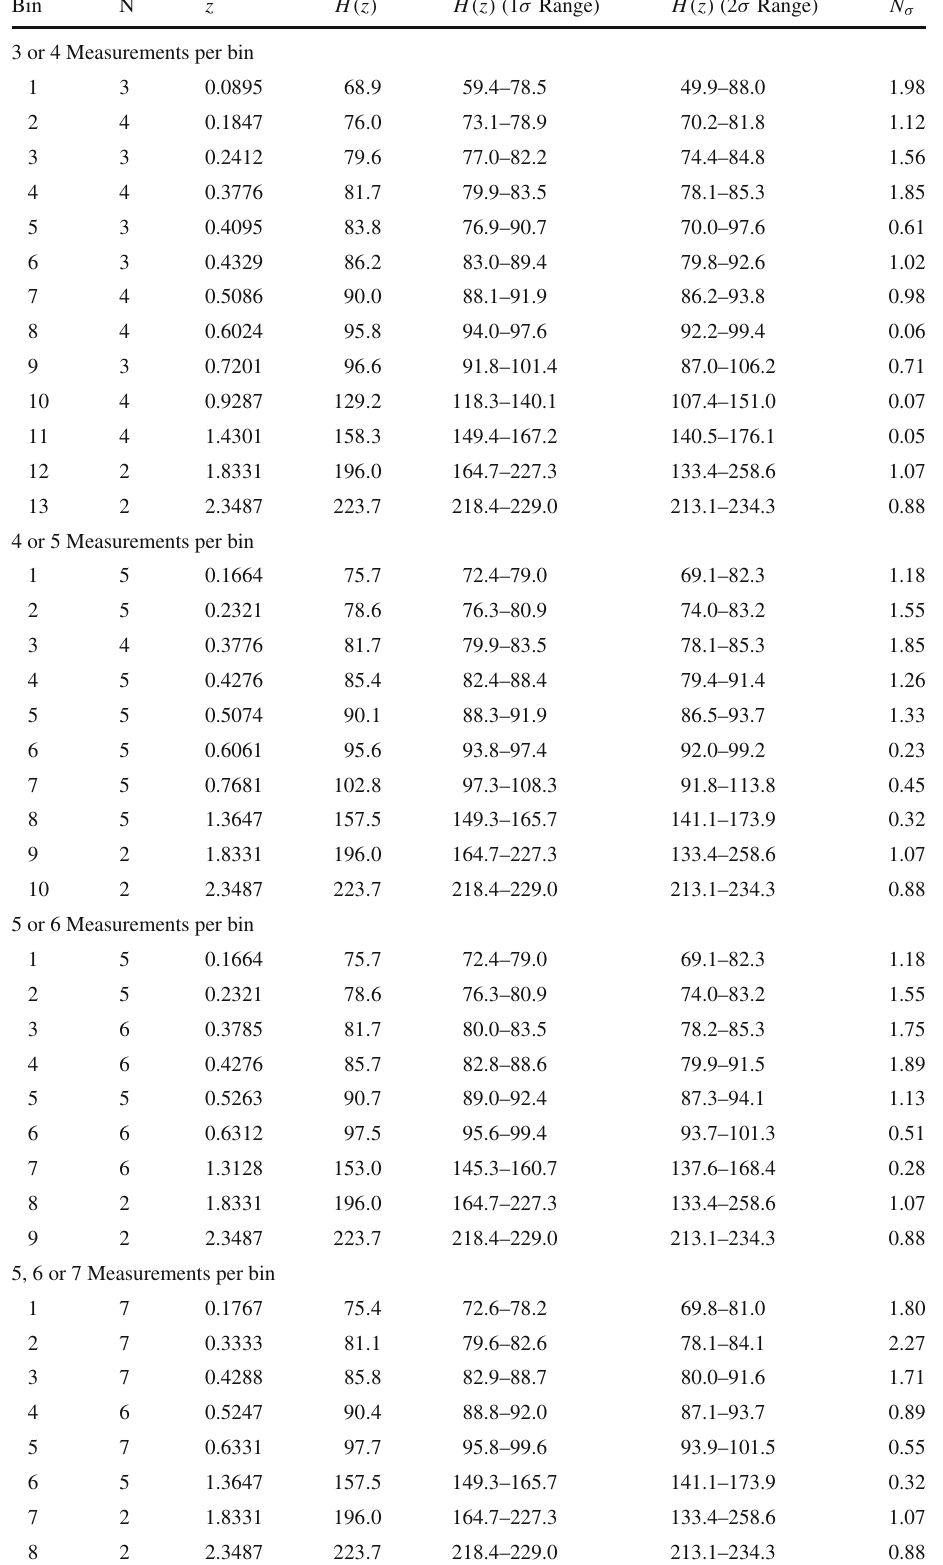
Results for 43 Redshift Measurements, where the unit of H ( z ) is km s − 1 Mpc −